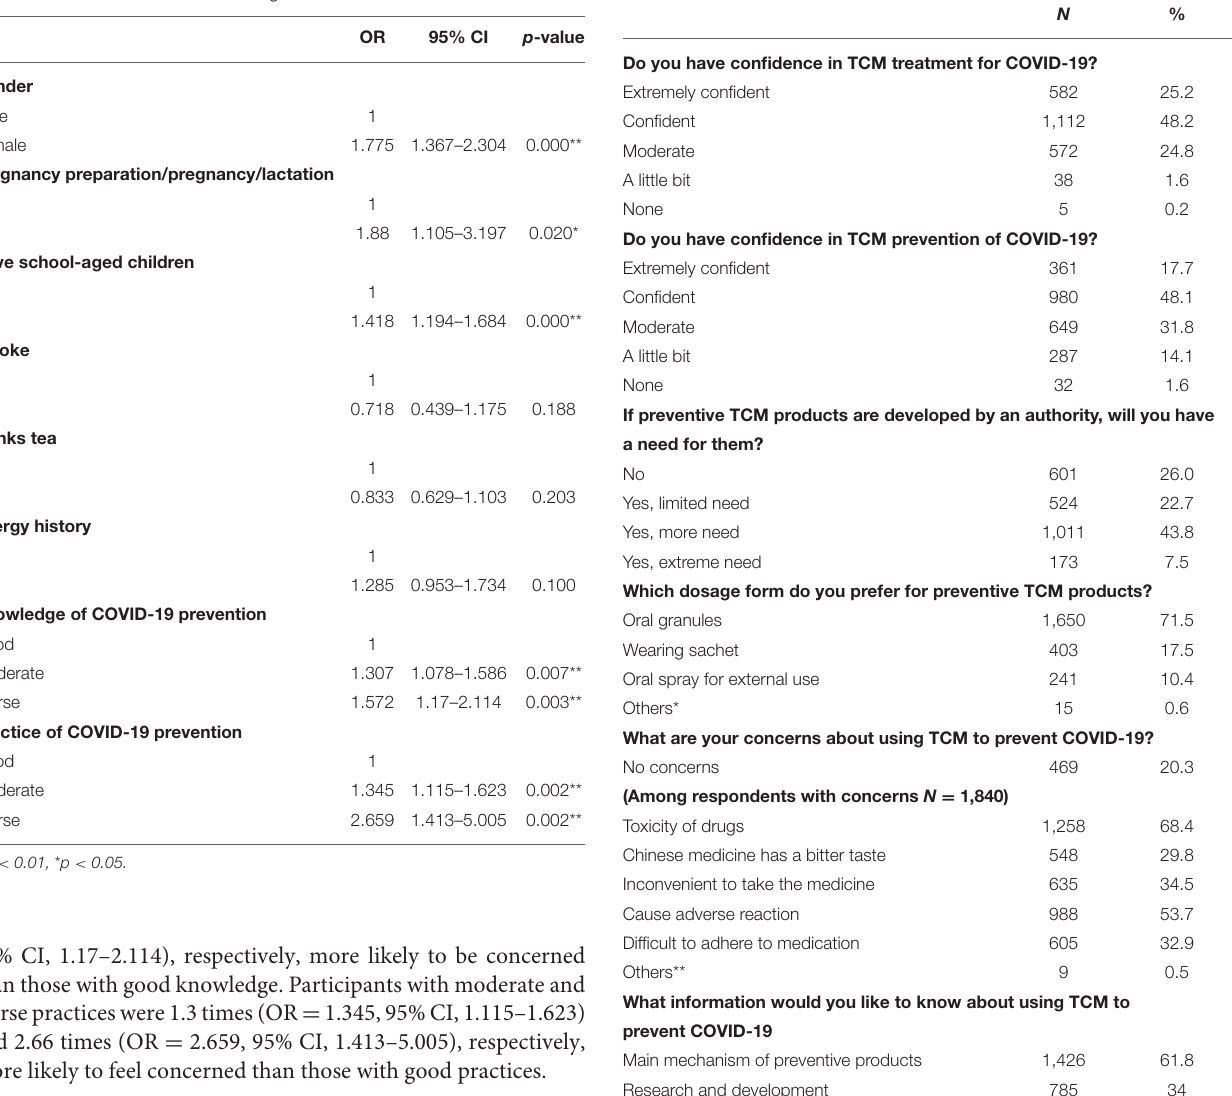
TABLE 7 | Attitudes and need regarding TCM COVID-19 prevention ( N =